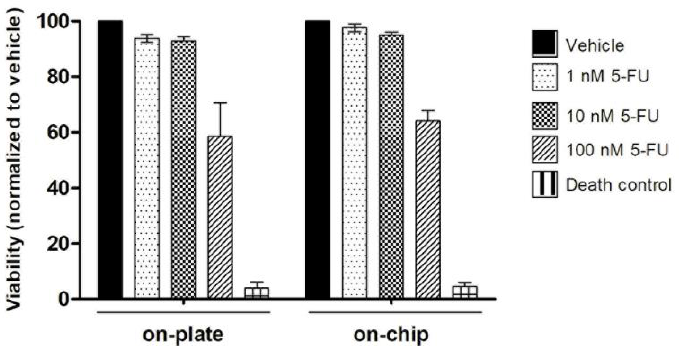
Figure 5. Analysis of organoid viability after treatment with 5-fluorouracil (5-FU). On day 4 of culture, the organoids were treated with 5-FU or 0.1% dimethyl sulfoxide (DMSO; control), and their viability was assessed on day 6. For the dead control, 30% of DMSO was used. The results are described as the mean ± SD of two wells per condition of two independent experiments. No significant differences were observed (Student’s t -test: * p ≤ 0.05; ** p ≤ 0.01; *** p ≤ 0.001).